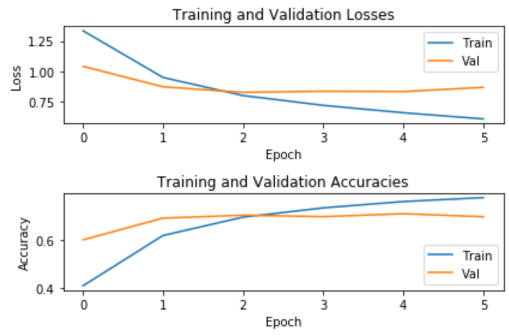
Figure 11. LSTM—loss and accuracy convergence.